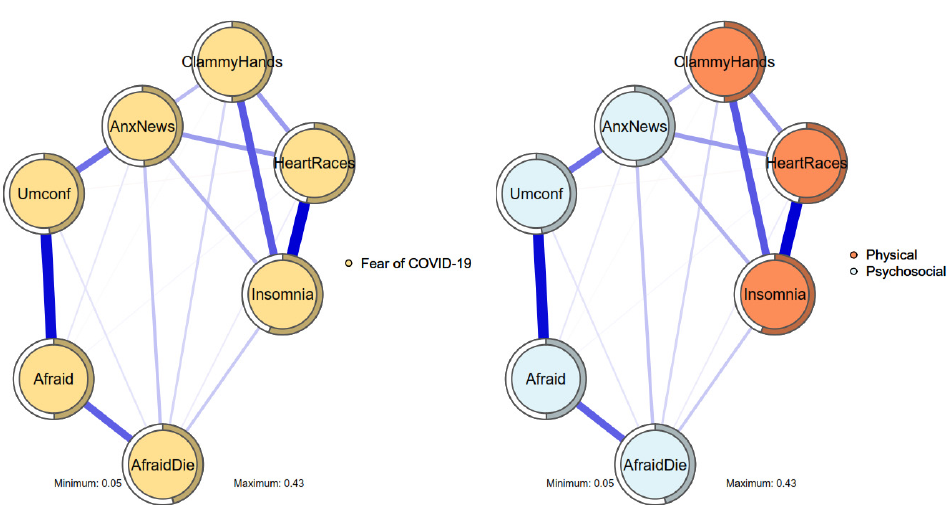
Figure 2. Estimated network of the FFMQ with the 1- and 2-factor solution Fruchterman–Reingold method. Note: Items are rounded in circles, with pies representing the explained variance (R 2 ) of each item. Lines connecting items represent correlations, blue = positive correlations, with thicker lines representing stronger correlations. Highly correlated items tend to be closer, while non-correlated nodes tend to be farther.